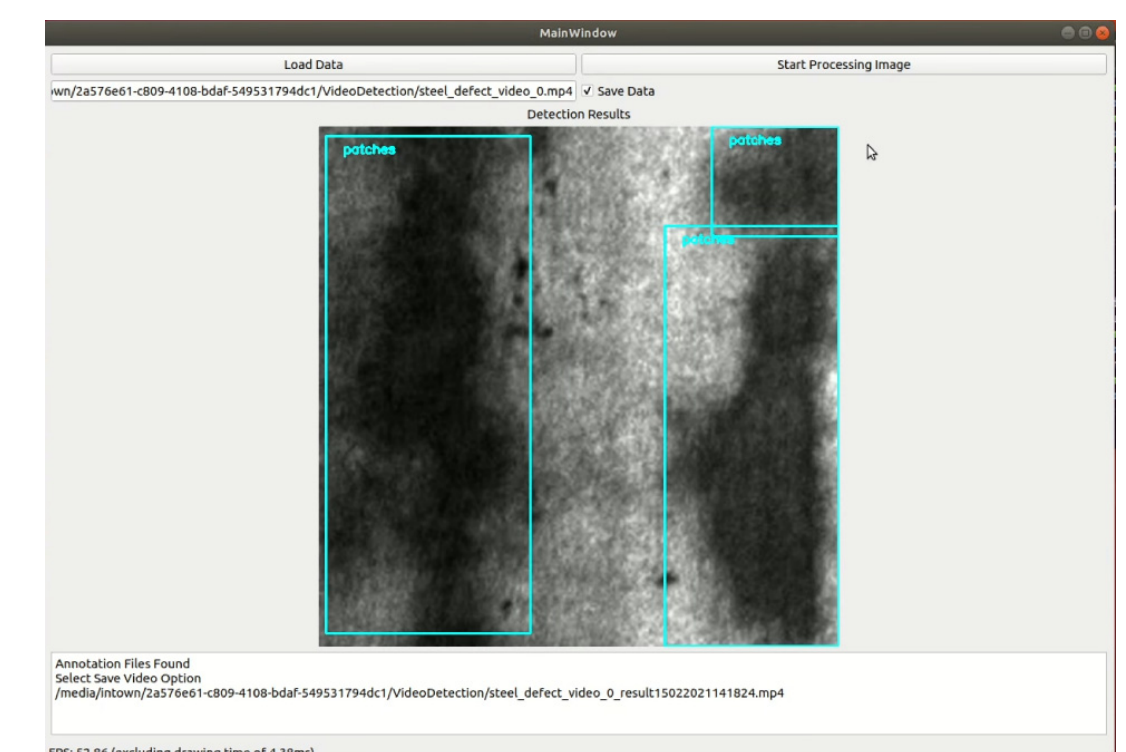
Figure 4. Example GUI of our demo application.